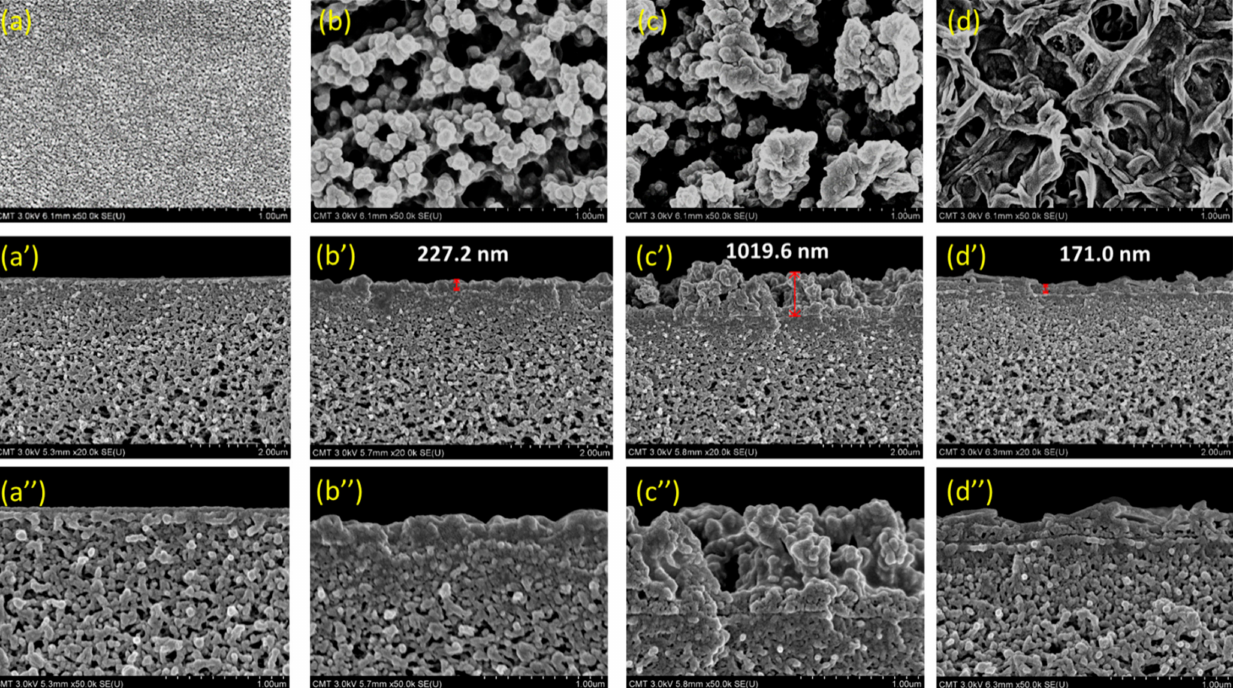
Figure 5. FESEM images: ( a , a ’, a ”) PSf support; ( b , b ’, b ”) DAPE-TMC; ( c , c ’, c ”) CHDA-TMC; ( d , d ’, d ”)